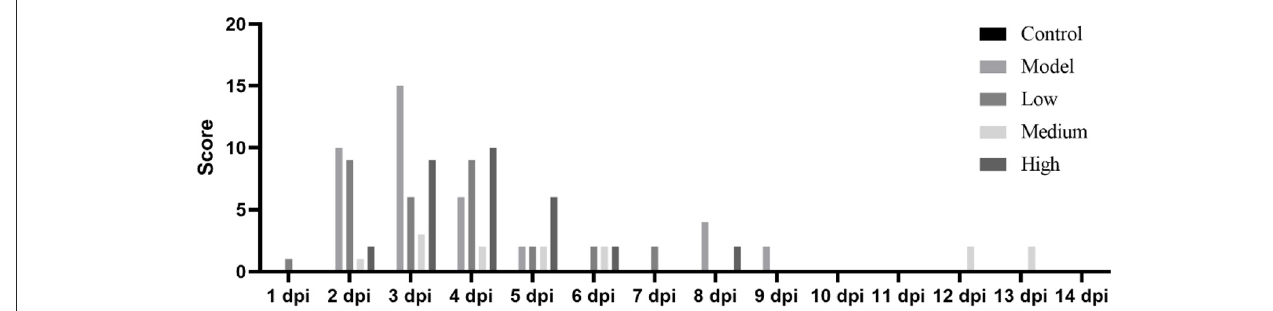
FIGURE3 Clinical symptom scores for piglets infected with SVV.